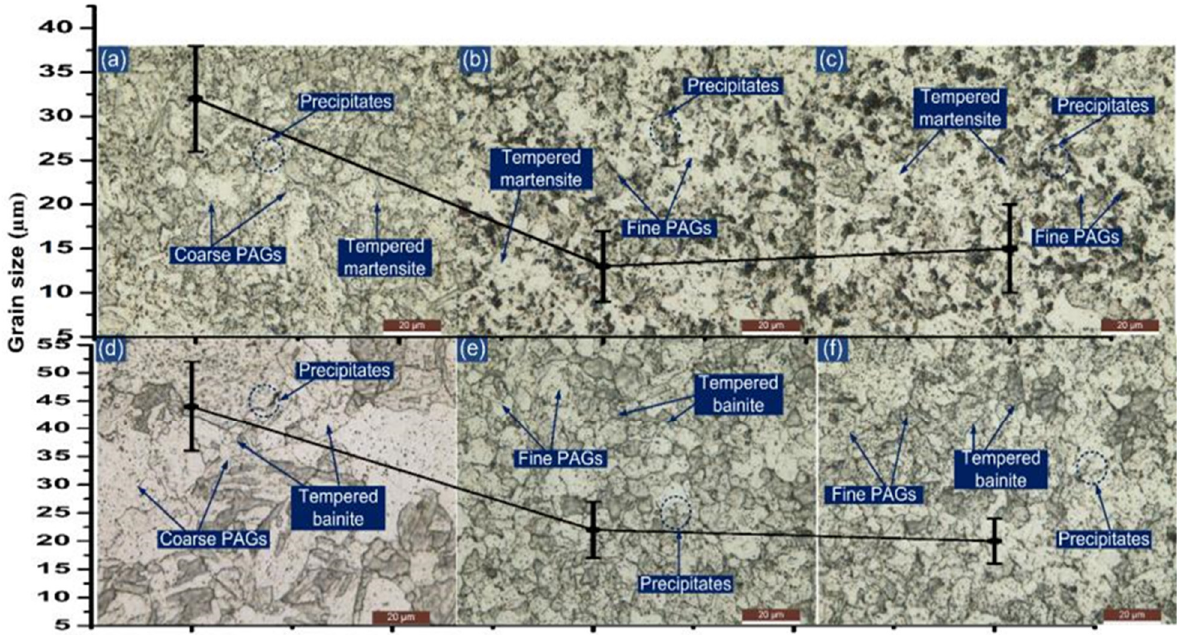
Figure 8. Typical optical image of HAZ region of P91 steel after PWHT: ( a ) coarse-grained HAZ, ( b ) fine-grained HAZ, ( c ) inter-critical HAZ; HAZ region of P22 steel: ( d ) coarse-grained HAZ, ( e ) fine-grained HAZ, ( f ) inter-critical HAZ.